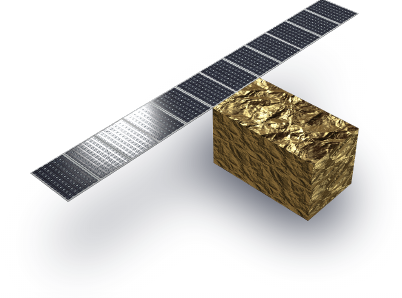
Figure 2. A schematic picture of a “typical” debris